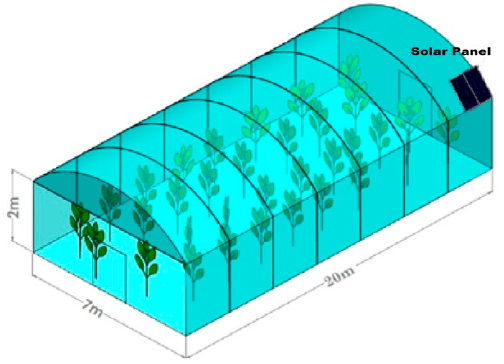
Figure 3. A schematic diagram of the greenhouse showing dimensions and the position of the solar panel on the roof of the greenhouse.